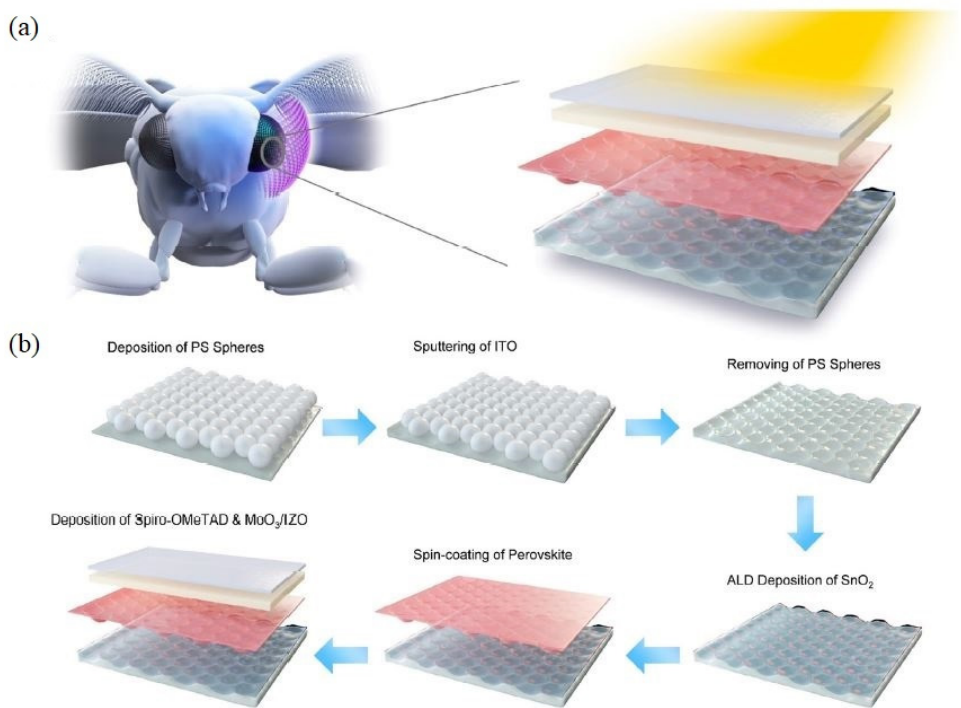
Figure 5. ( a ) Moth compound eye and schematic of the moth-eye inspired structure. ( b ) Illustration of the fabrication process of the sTPV device based on Cs 0.05 FA 0.83 MA 0.12 PbBr 0.33 I 0.27 perovskite. Here, PS stands for polystyrene, ALD for atomic layer deposition, Spiro-OMeTAD for 2,2 ′ ,7,7 ′ - Tetrakis[N,N-di(4-methoxyphenyl)amino]-9,9 ′ -spirobifluorene, and IZO for indium zinc oxide.